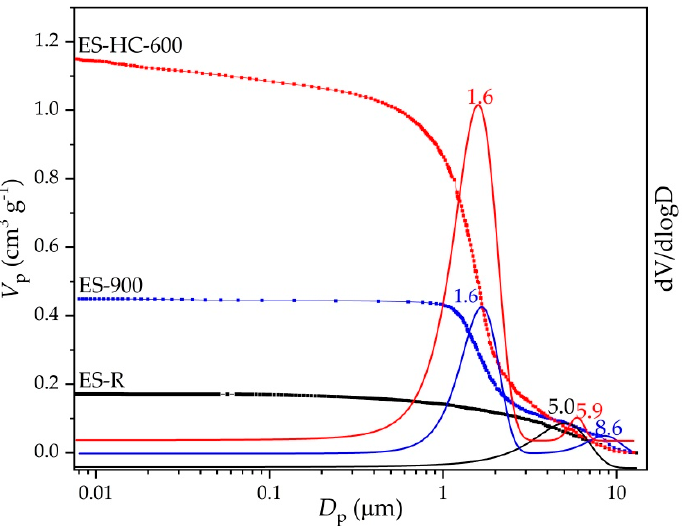
Figure 4. Cumulative volume intrusion and pore size distribution of ES-R, ES-900, and ES-HC-600.